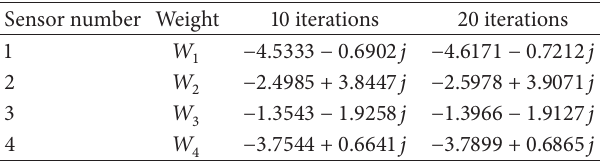
Table 2: Weight vector after 10 and 20 iterations for one user at 40 ∘ and interference at 50 ∘ and 30 ∘ .